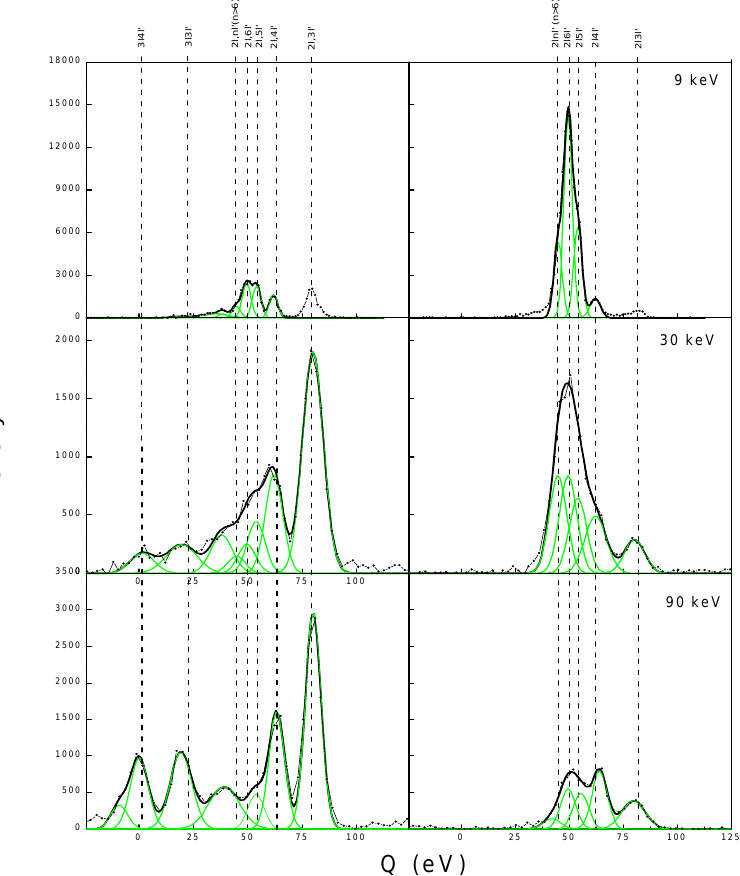
Figure 3. Experimental Q-value distributions for autoionizing (left side) and radiative (right side) DC